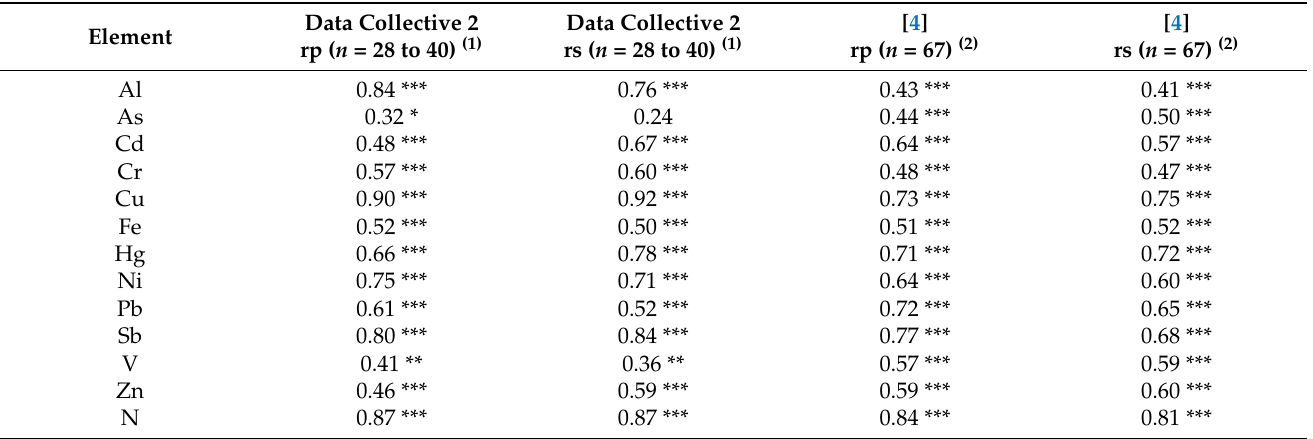
Table 3. Comparison of the correlation coefficients (Pearson, Spearman) between the quotients of the element contents in mosses and the quotients of the leaf area indices with the results of